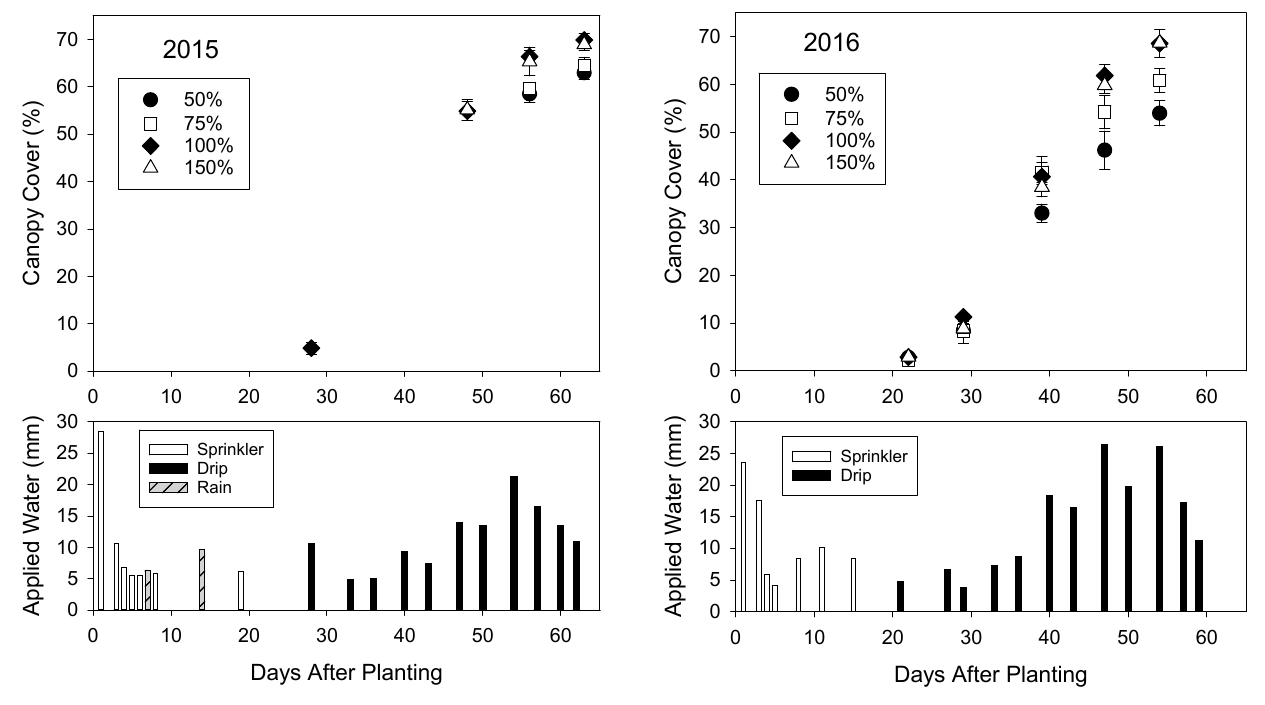
Figure 1. Measured canopy cover of the irrigation treatments ( top ) and applied water volumes of the 100% treatment ( bottom ) for trials 1 and 2. No rainfall occurred during trial 2. Treatments are 50–150% of crop water requirement. Table 1. Applied water for trials 1 (2015) and 2 (2016). Treatments are 50–150% of crop water re- quirement.